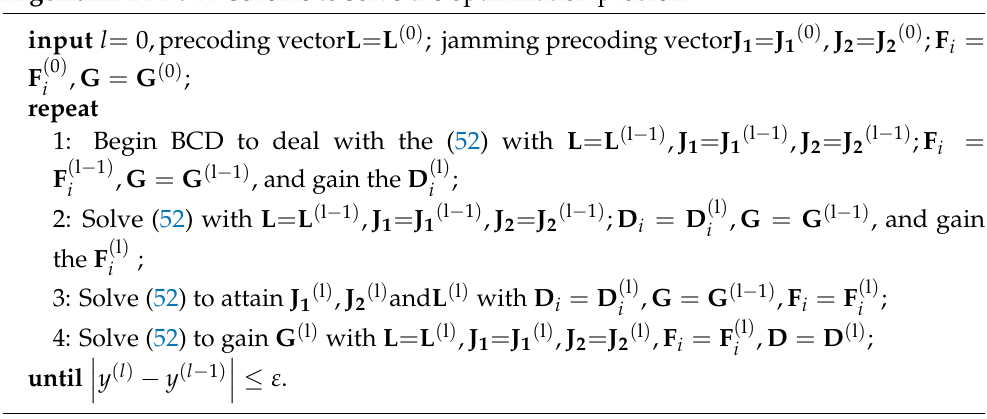
Algorithm 1 AN-BF scheme to solve the optimization